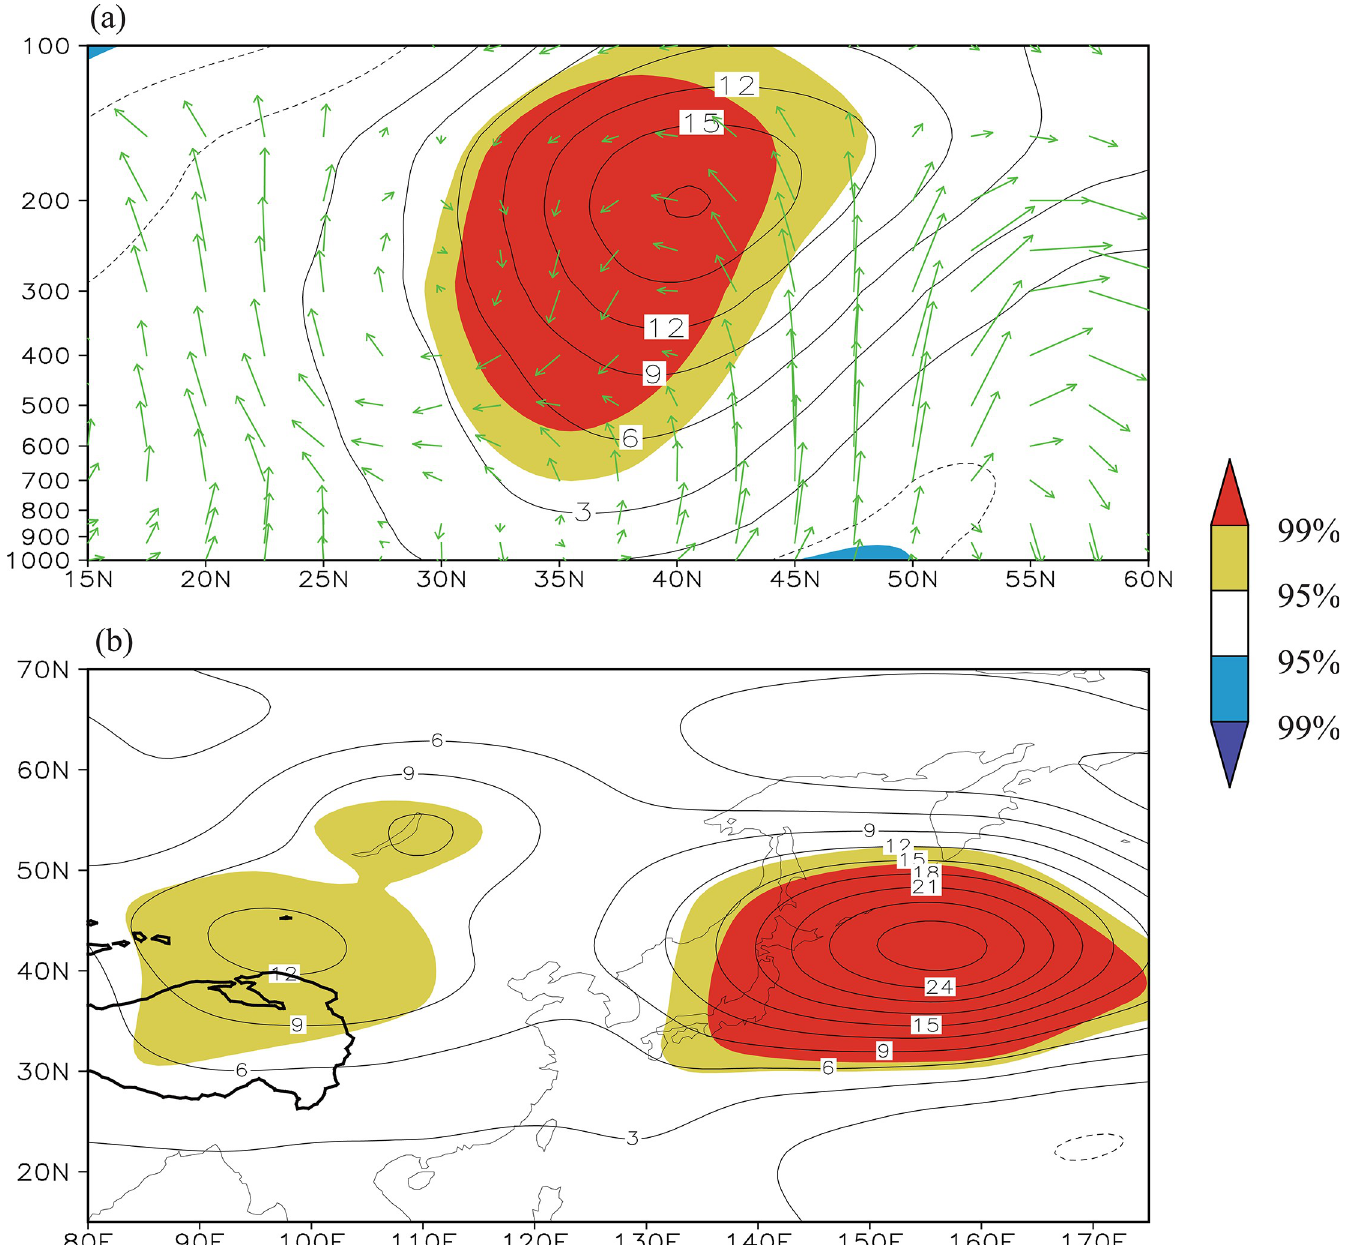
Fig 12. (a) Summer vertical motion and geopotential height anomalies regressed upon the northwest Pacific Ocean SST index on a cross section along 155˚E. (b) The 200 hPa geopotential height anomalies regressed on the regional mean 200-hPa geopotential height to the east of Japan (32–42˚ N, 145–165˚ E) during the time period 1982–2014. The yellow (red) shading denotes a positive correlation significant at the 95% (99%) confidence level and the blue (purple) shading denotes a negative correlation significant at the 95% (99%) confidence